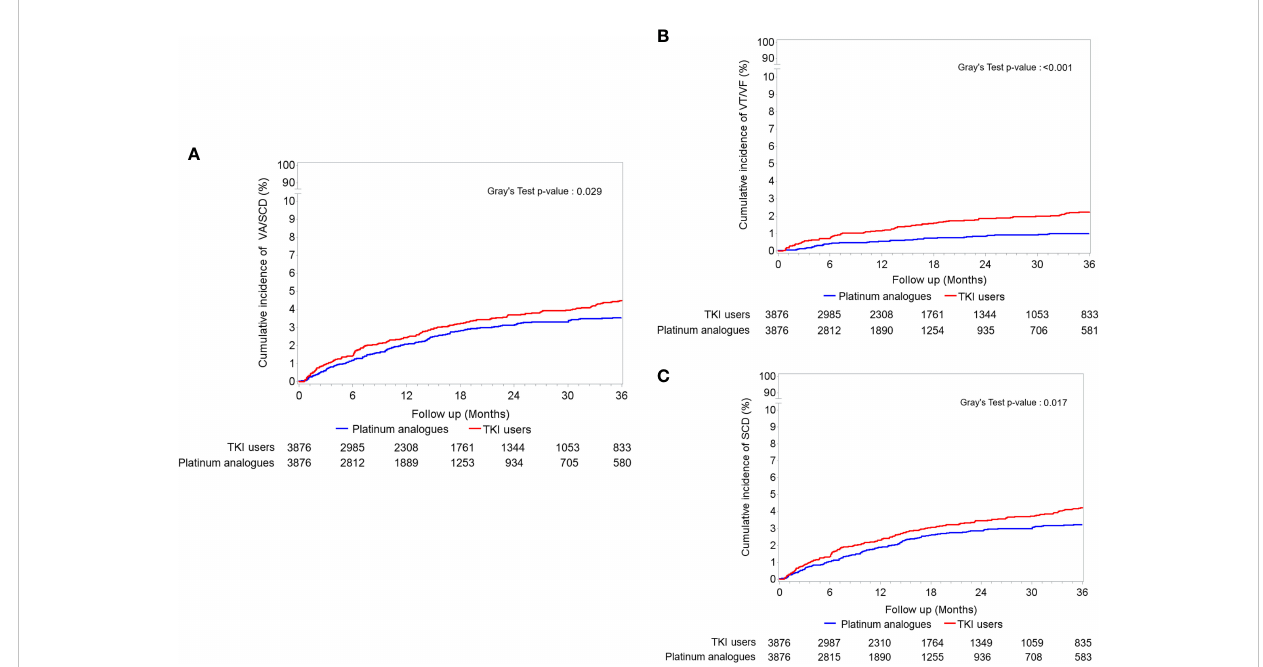
FIGURE 1 The accumulating incidences of (A) the composition endpoint of ventricular arrhythmia (VA) and sudden cardiac death (SCD), (B) only VA including ventricular tachycardia (VT)/ventricular fi brillation (VF), and (C) only SCD between tyrosine kinase inhibitor (TKI) and platinum analogue users in patients with non-small cell lung cancers (NSCLCs).